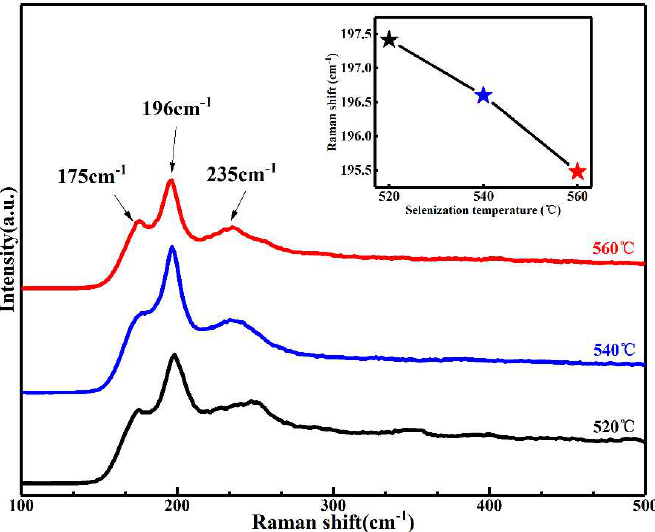
Figure 2. Raman patterns of Na-doped Cu 2 ZnSn(S,Se) 4 films selenized at different temperatures. Inset: location tracking of the main Raman peak of the A1 mode. Inset: location tracking of the main Raman peak of the A1